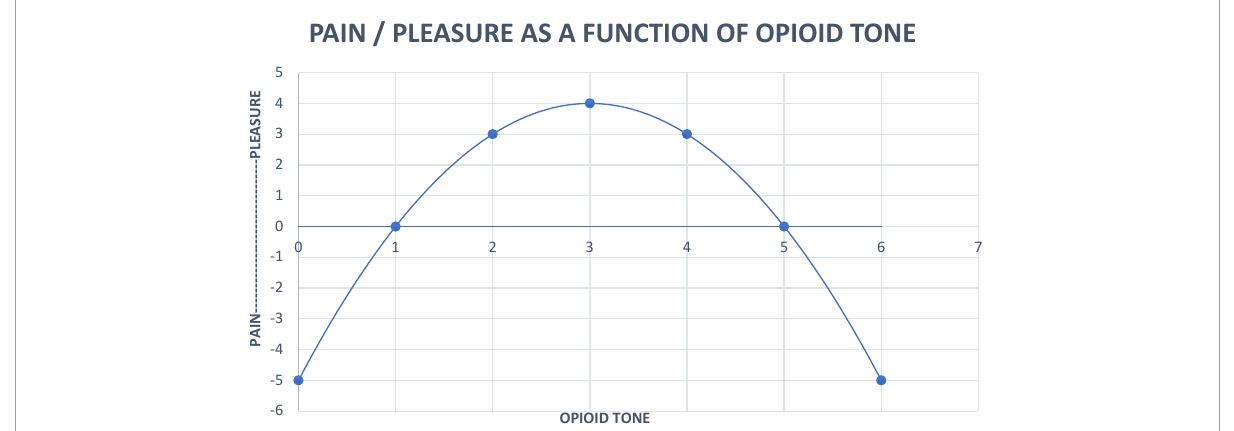
FIGURE1 Neurobiological systems engineering model of the relationship of pain, pleasure and opioid